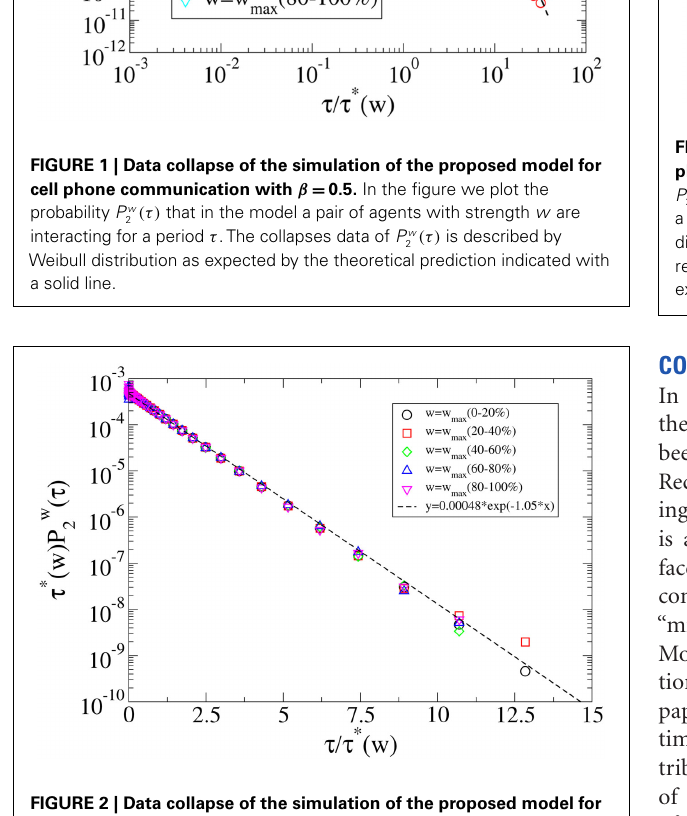
exponents predicted by the mean-field solution of the model.